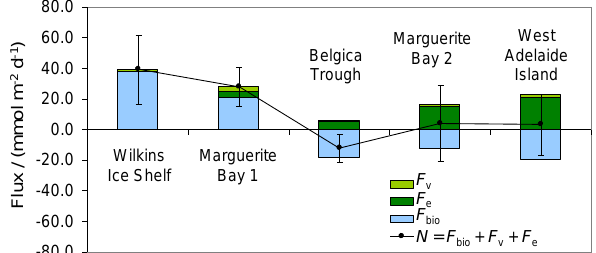
Fig. 7. Representation of O 2 fluxes ( F e , F v and F bio in mmolm − 2 d − 1 ) in the WSIZ and POOZ. Positive values indicate flux out of the mixed layer. The total N is depicted as a black line, with corresponding error bars representing the error after quantifi- cation of physical